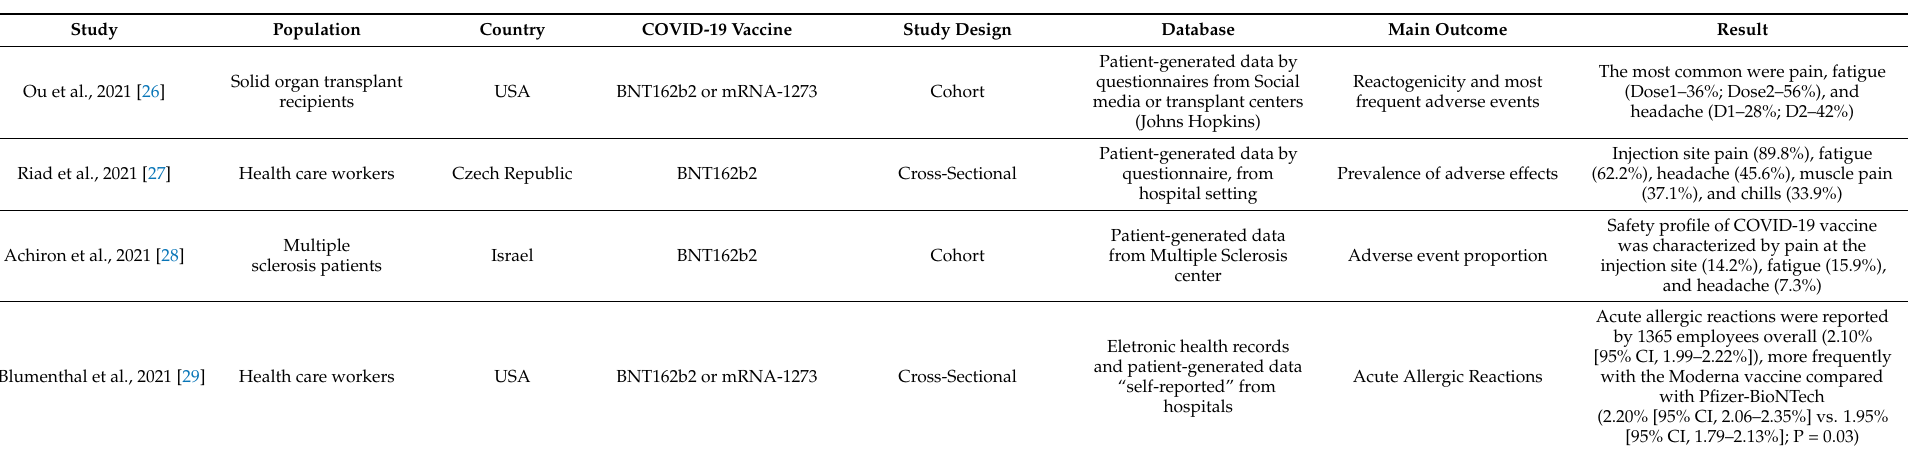
Table 3. Characteristics of studies included assessing the safety of COVID-19